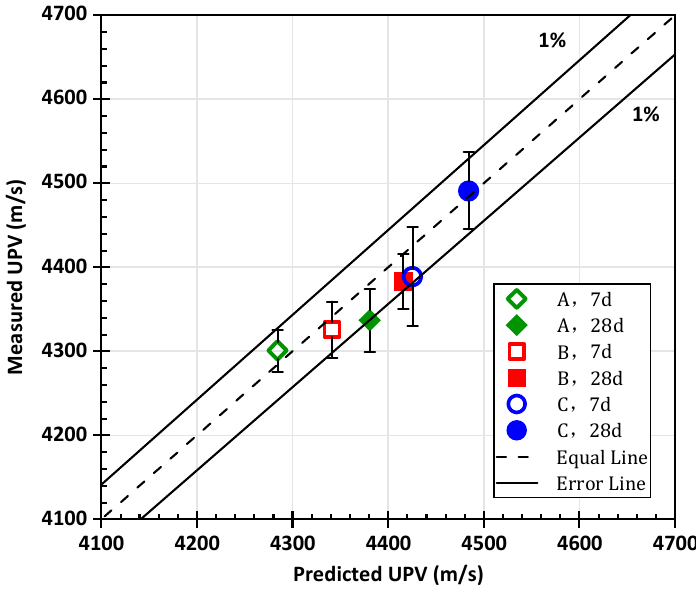
Figure 14. The comparison diagram between the predicted value of the multiscale UPV model and the measured value.